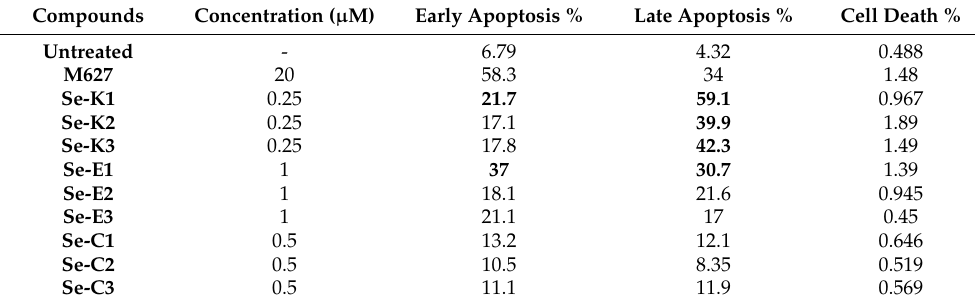
Table 3. Apoptosis induction in Colo 320 cell line by symmetrical selenoesters.